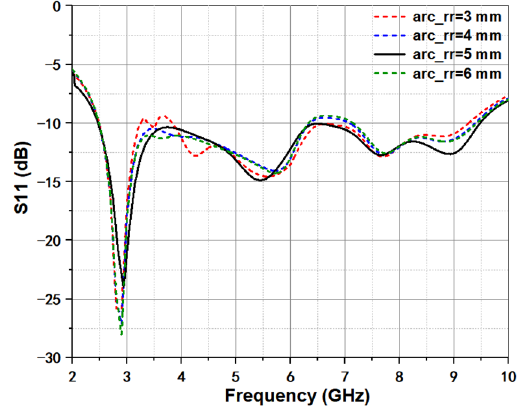
Figure 3. Simulated return loss under different fillet radius arc_rr.